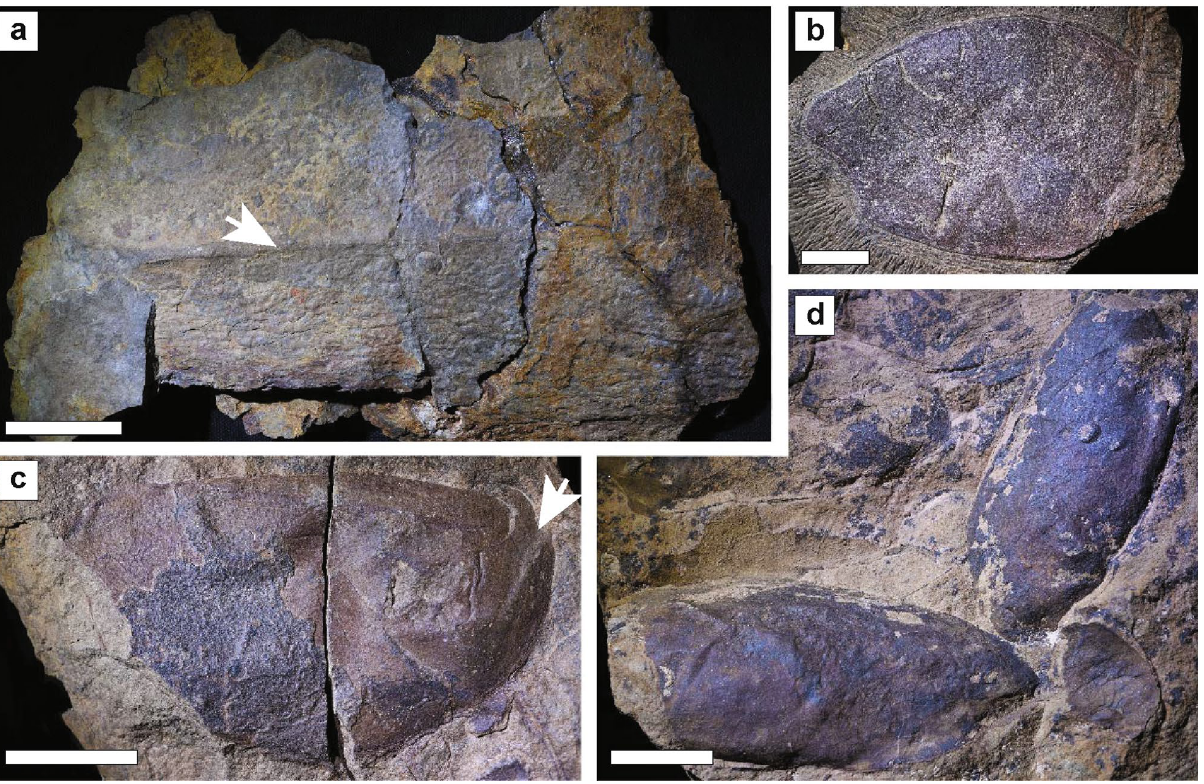
Figure 4. Euarthropod fossils from Taichoute interval a2. ( a ) Large carapace with central carina (white arrow), similar to that seen in Aegirocassis dorsal carapace elements 6 . Note the presence of a brachiopod on the right side under the Carina. ( b ) Carapace with an asymmetrically rounded outline with an anterior protrusion similar to that seen in lateral carapace elements of hurdiids 60 . ( c ) Carapace with an asymmetrically rounded outline with one side bearing a structure similar to the upturned projection (white arrow) described for Aegirocassis lateral carapace elements 6 . ( d ) Assemblage with at least three carapaces together, some of which are elongated and tapering at one end, with a partial outline possibly resembling that of lateral carapace elements of hurdiids 6 . Scale bars are 4 cm in a, and 3 cm in b, c, d. By order from a to d: MCZ.IP.198899, MCZ.IP.19890, MCZ. IP.198902, and MCZ.IP.198901. All four specimens are housed at the Museum of Comparative Zoology, Harvard University,